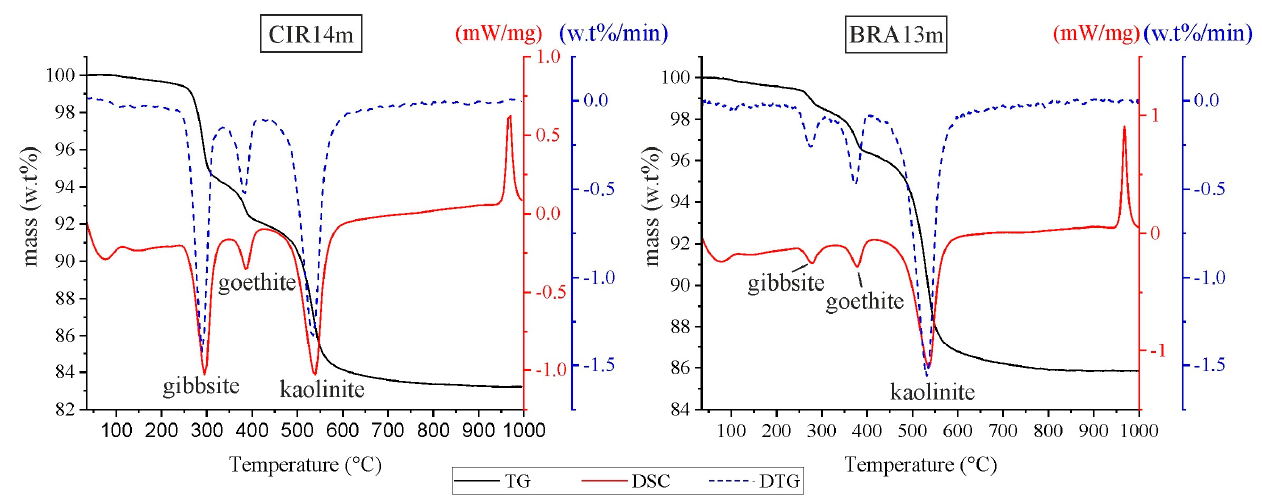
Figure 9. Thermal analysis of the BTC samples CIR14m and BRA13m. Heating rate 10 K/min. TG: termogravimetric curve; DTG: first derivate of TG and; DSC: differential scanning calorimetry.